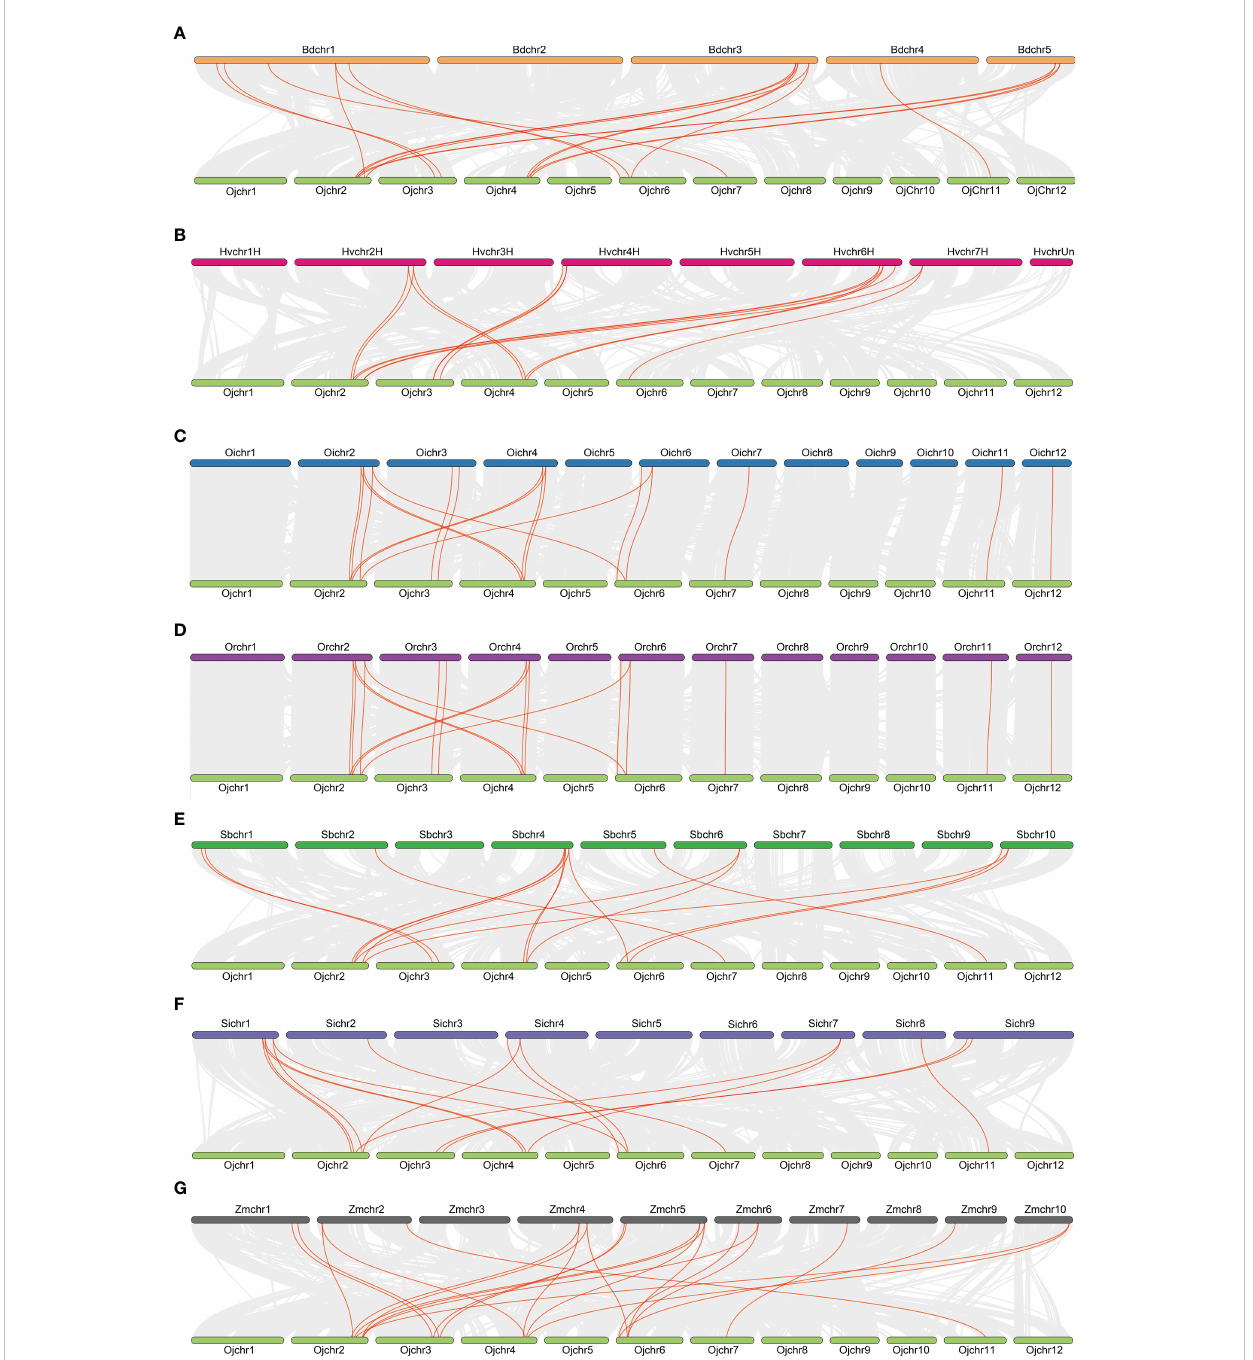
FIGURE 3 Collinearity relationships of GRFs in eight species or subspecies. Brachypodium distachyon (A) , Hordeum vulgare (B) , Oryza sativa L. ssp. indica, (C) , Oryza sativa L. ssp. japonica (D) , Sorghum bicolor (E) , Setaria italic (F) , Zea mays (G)